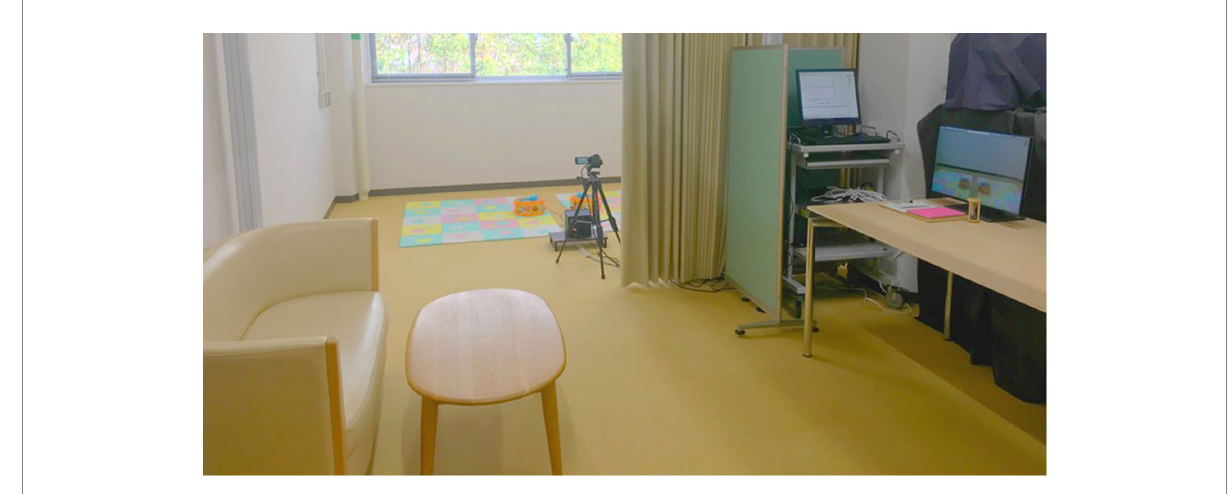
FIGURE 1 Waiting area (front) and experimental space (back) of this